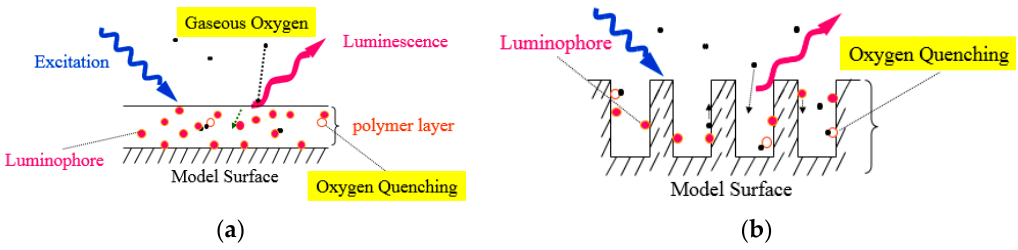
Figure 1. Schematic description of ( a ) a polymer pressure-sensitive paint (PSP) and ( b ) a porous PSP.